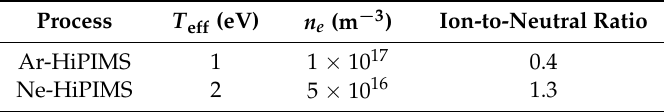
Table 1. The plasma parameters, electron temperature T eff and plasma density n e , together with an ion-to-neutral ratio of the Ar- and Ne-HiPIMS discharges.